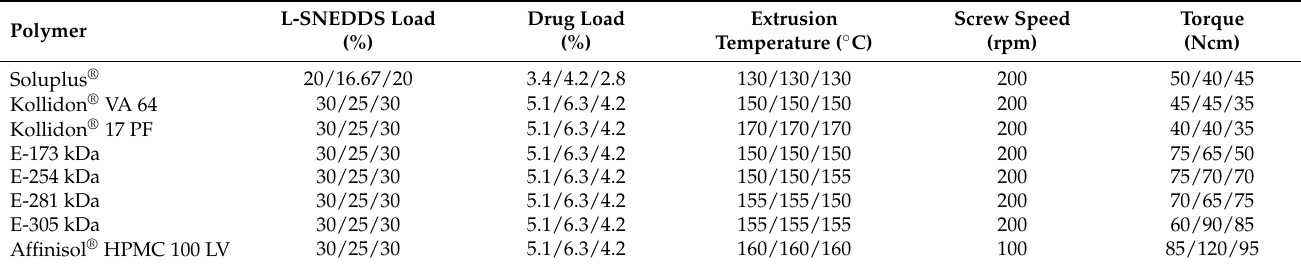
Table 2. Composition and hot melt extrusion process parameters of Solid-SNEDDS (S-SNEDDS) incorporating